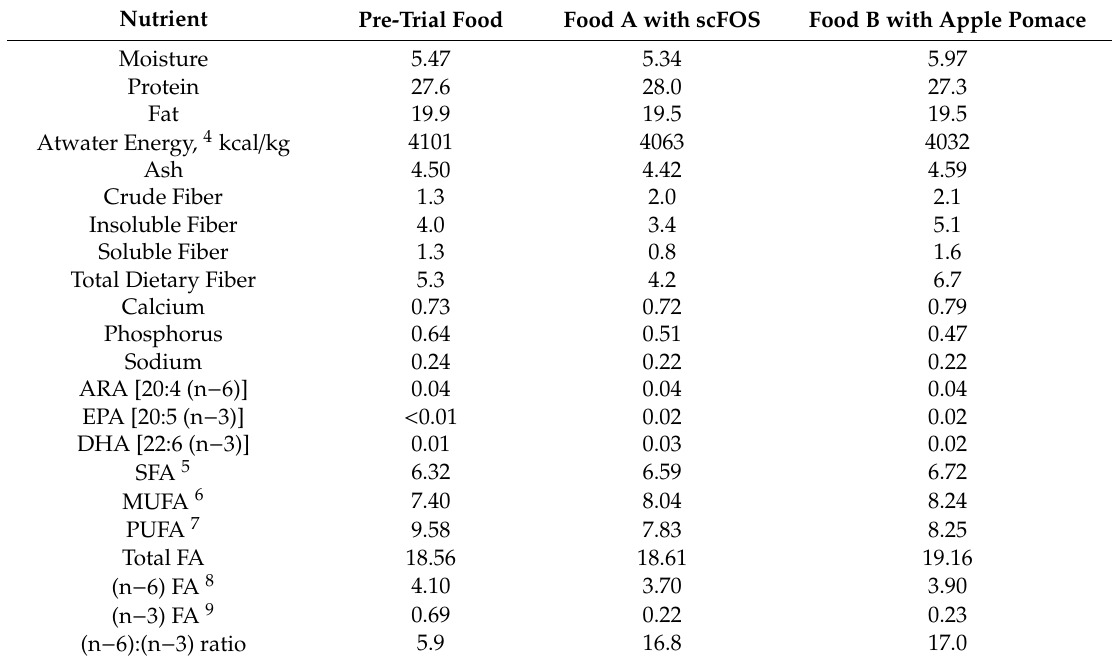
Table 5. Composition of pre-trial food 1 , Food A 2 , and Food B 3